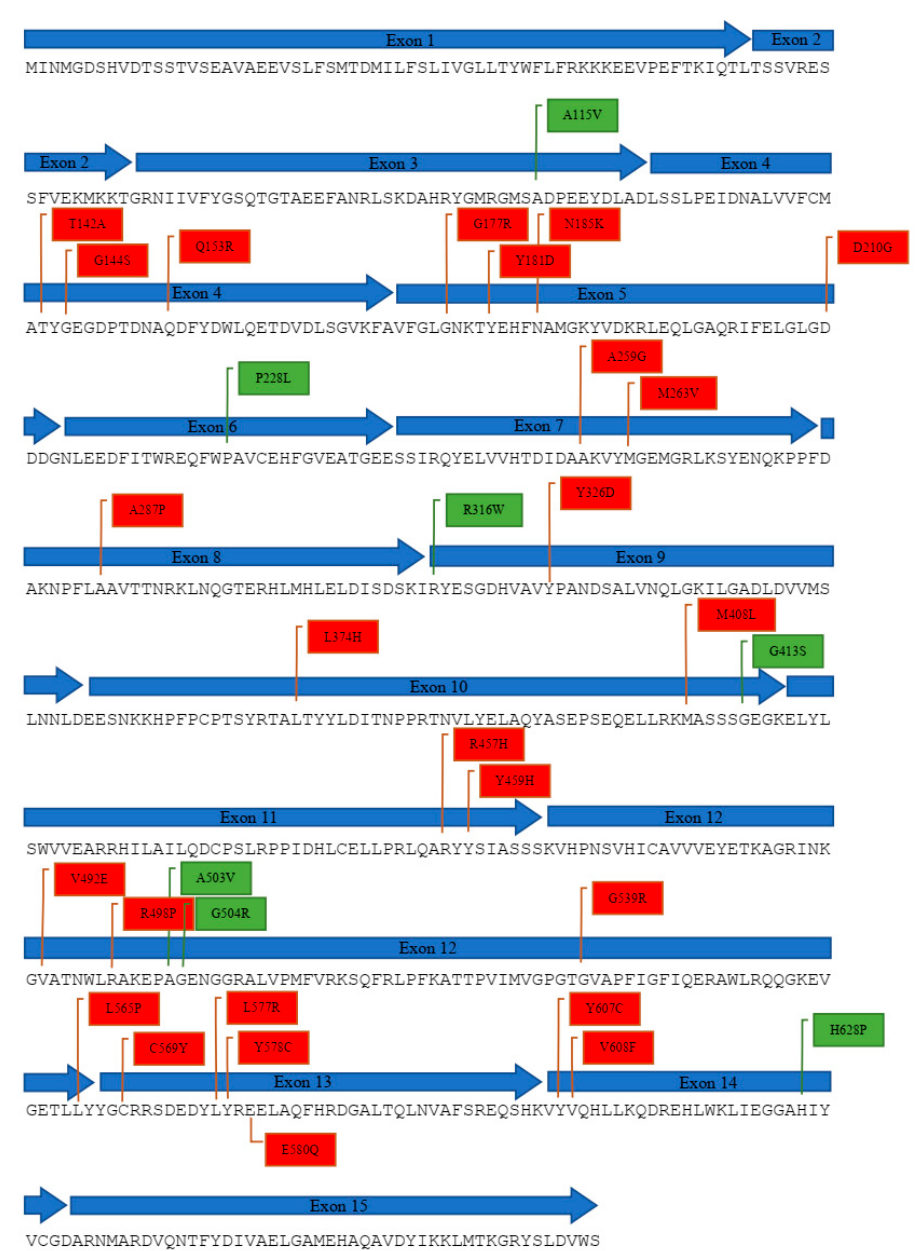
Figure 4. POR protein sequence of Homo Sapiens (NM_000932.3) showing all POR genetic variants due to missense mutations that were reported at their corresponding exon. Red boxes indicate mutation variants found in PORD patients, while green boxes indicate polymorphic variants detected in healthy individuals.